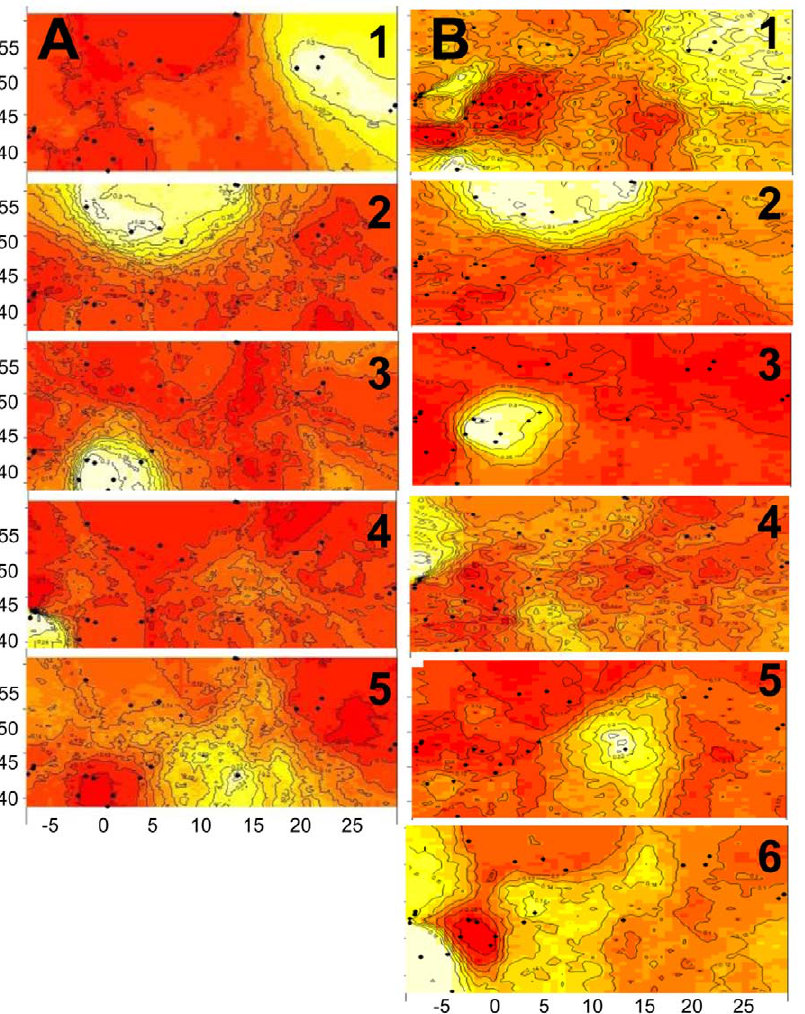
Figure 4. Spatial output from GENELAND using all 22 I.elegans populations (A) and (B) all 22 I.elegans populations and the four I. graellsii populations. Black circles indicate the relative positions of the sampled populations (see Figure 1). Darker and lighter shading are proportional to posterior probabilities of membership in clusters, with lighter (yellow) areas showing the highest posterior probabilities of clusters.